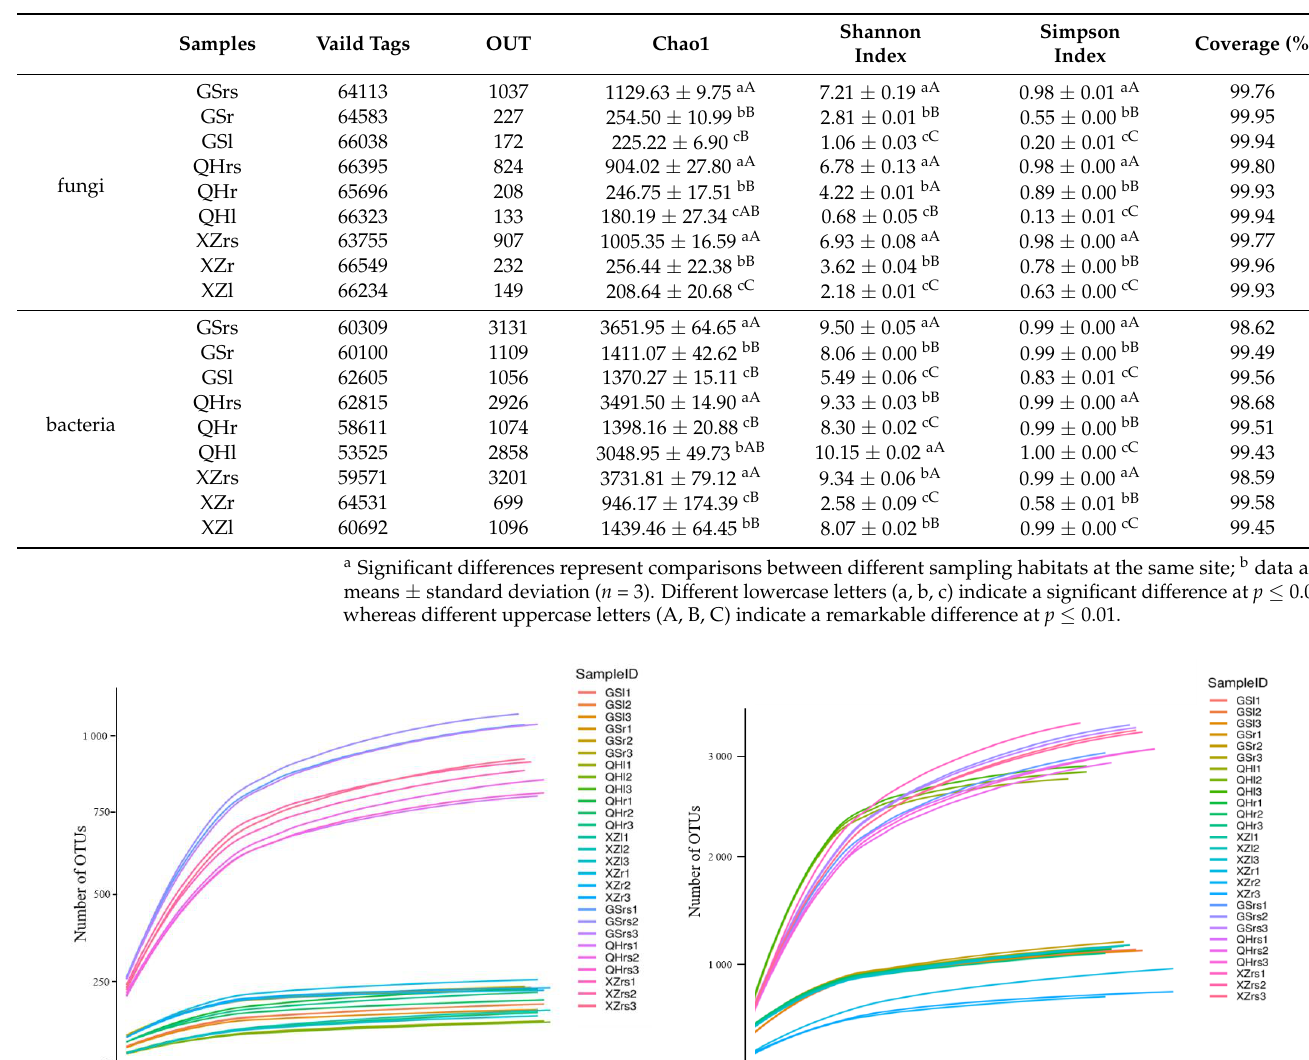
Table 1. Diversity index of fungal and bacterial communities associated with S . purpurea .